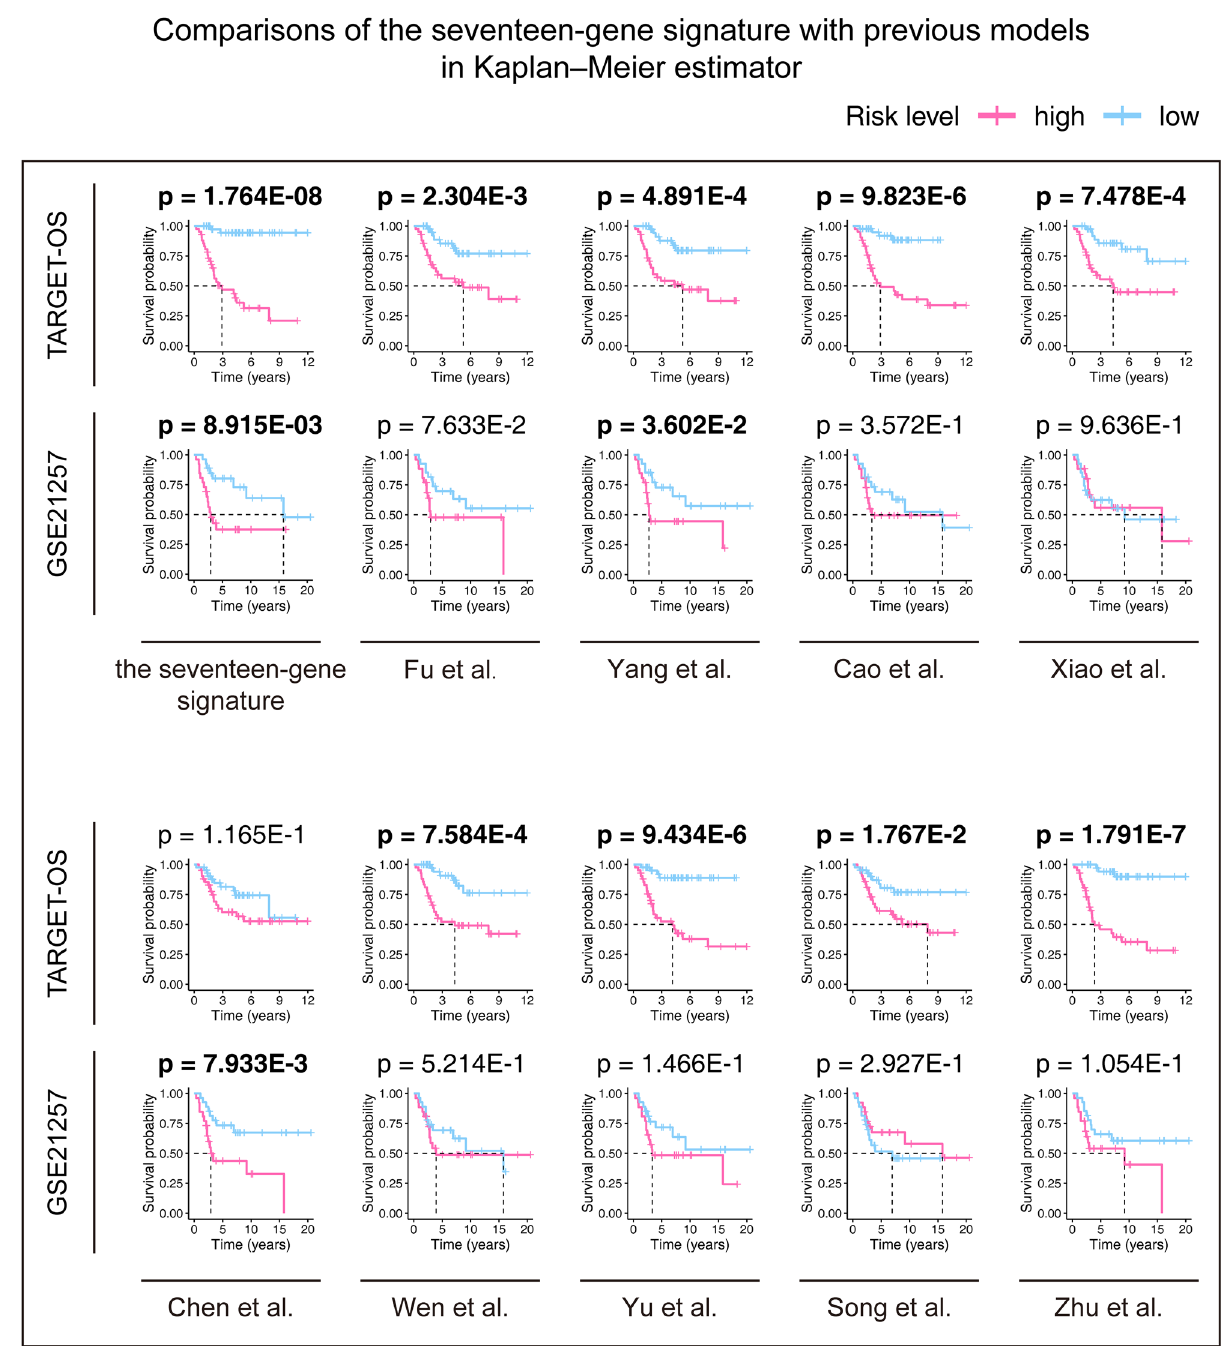
Figure 7. Comparisons between the seventeen-gene signature and previous studies conducted in the training and validation cohorts using Kaplan–Meier estimator. The two-sided log-rank test measured the differences between the high- and low-risk groups. The bold p value indicates that < 0.05, which considers